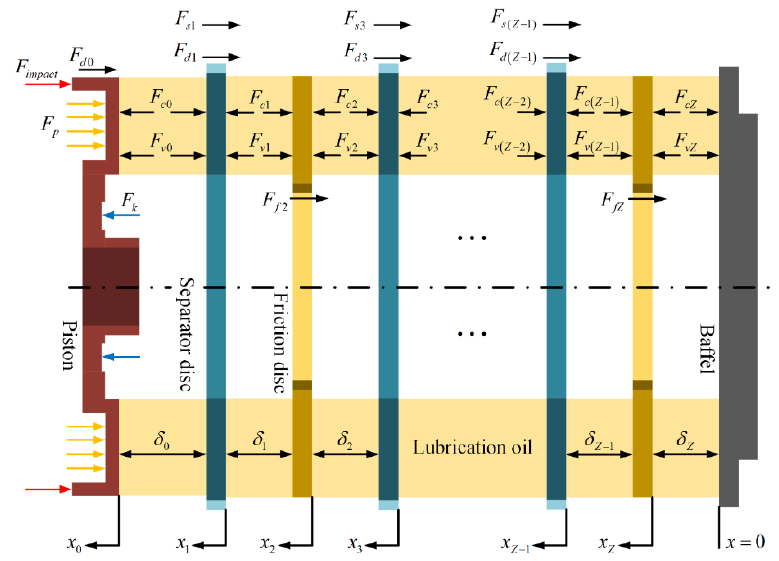
Figure 2. Force analysis of the wet multi-disc clutch.